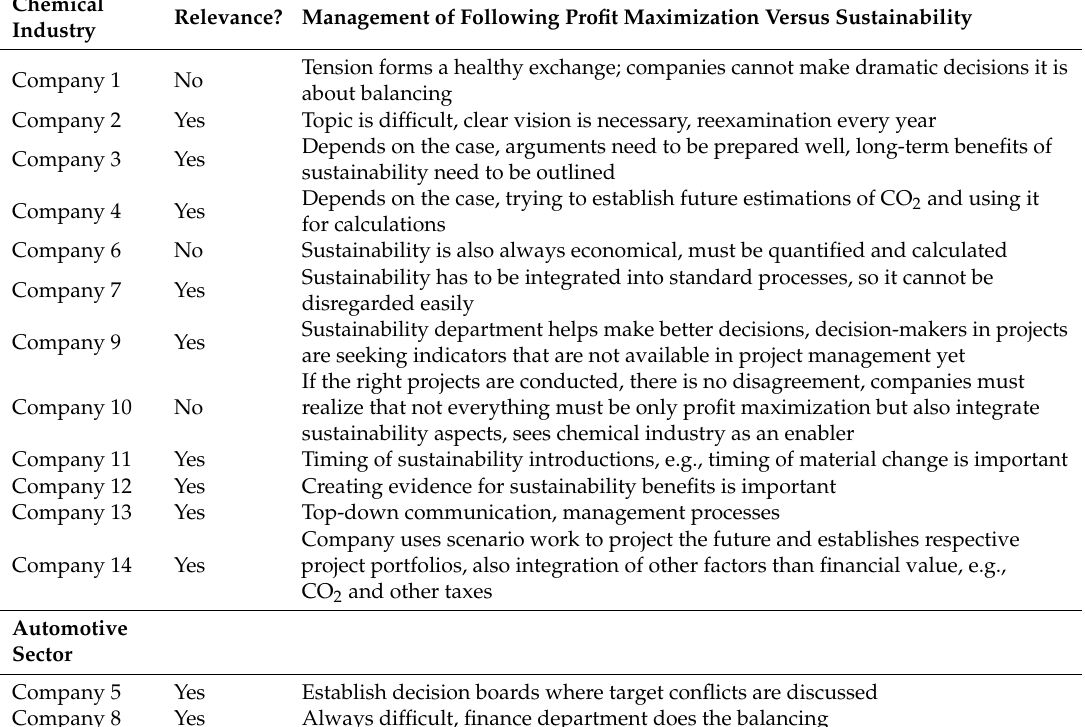
Table 7. Results of interview question 9 on relevance of profit maximization for sustainability targets and possible